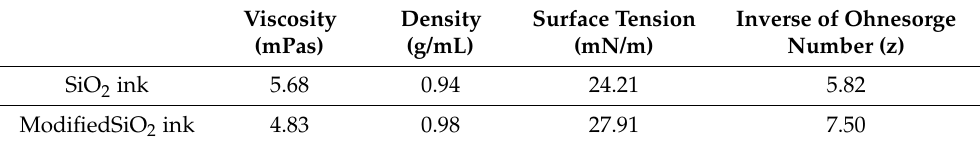
Figure 2. ( a ) TEM image of sol-gel synthesized nano SiO 2 ; ( b ) photographs of photo-curable nano SiO 2 ink; and ( c ) the contact angle of photo-curable nano SiO 2 ink. Table 1. Rheological properties of photo-curable nano SiO 2 ink and modified nano SiO 2 ink.